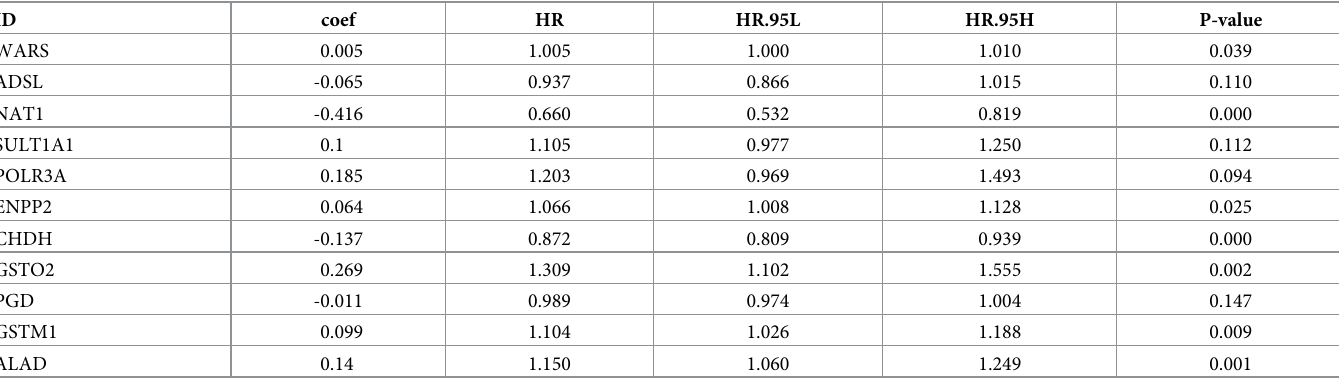
Table 2. The genes used to construct the model and their corresponding risk coefficient.